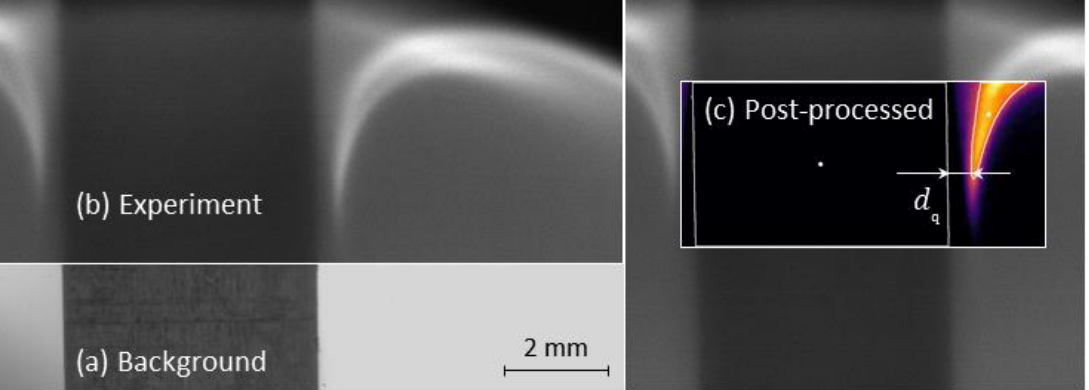
Figure 4. Schematic of the post-processing to assess the quenching distance. ( a ) Bright background image of the quenching object. ( b ) Image of the sidewall flame quenching during the experiment. ( c ) Post-processed image with marked object and flame contours by white lines.